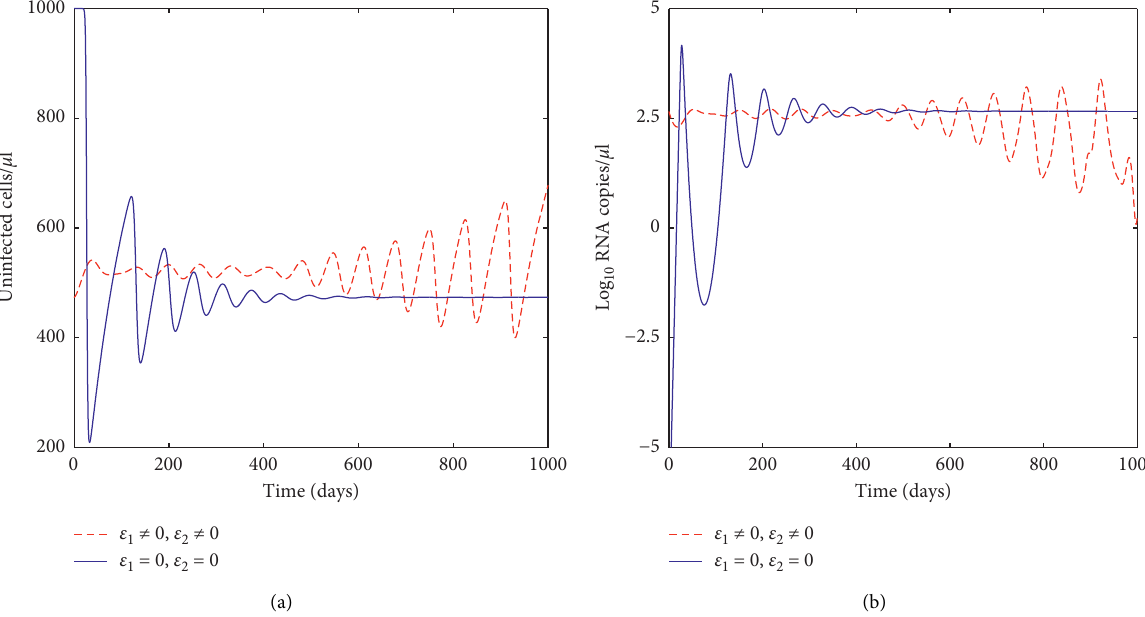
≠ 0 and ε ≠ 0. Solid lines 1 2